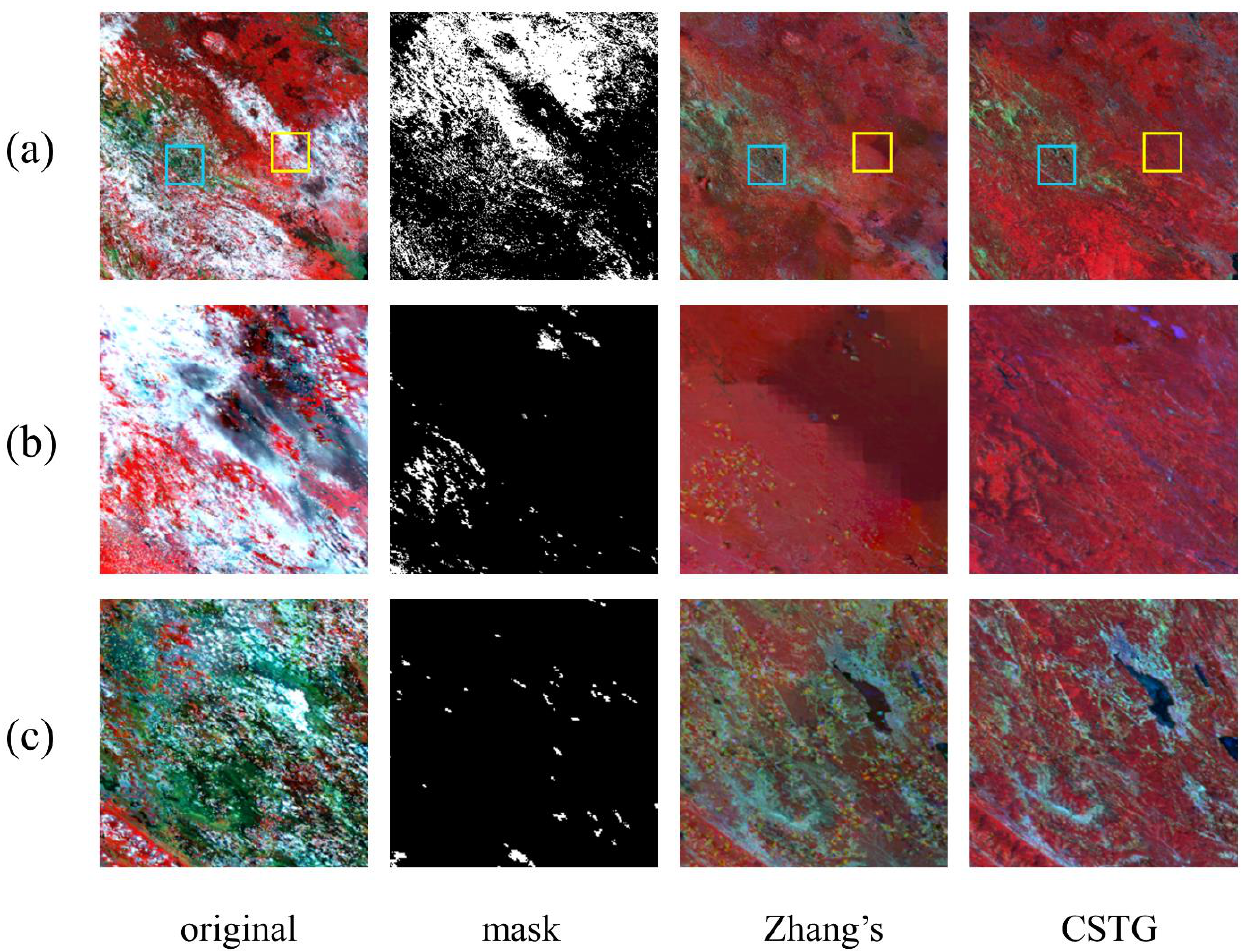
Figure 10. Recovery results for an individual image using different methods are shown for ( a ) the entire images, ( b ) the zoomed-in images as marked by the yellow rectangle in ( a ), and ( c ) the zoomed-in images as marked by the blue rectangle in ( a ). The black parts masks are cloudy areas and the white parts are cloud-free areas.